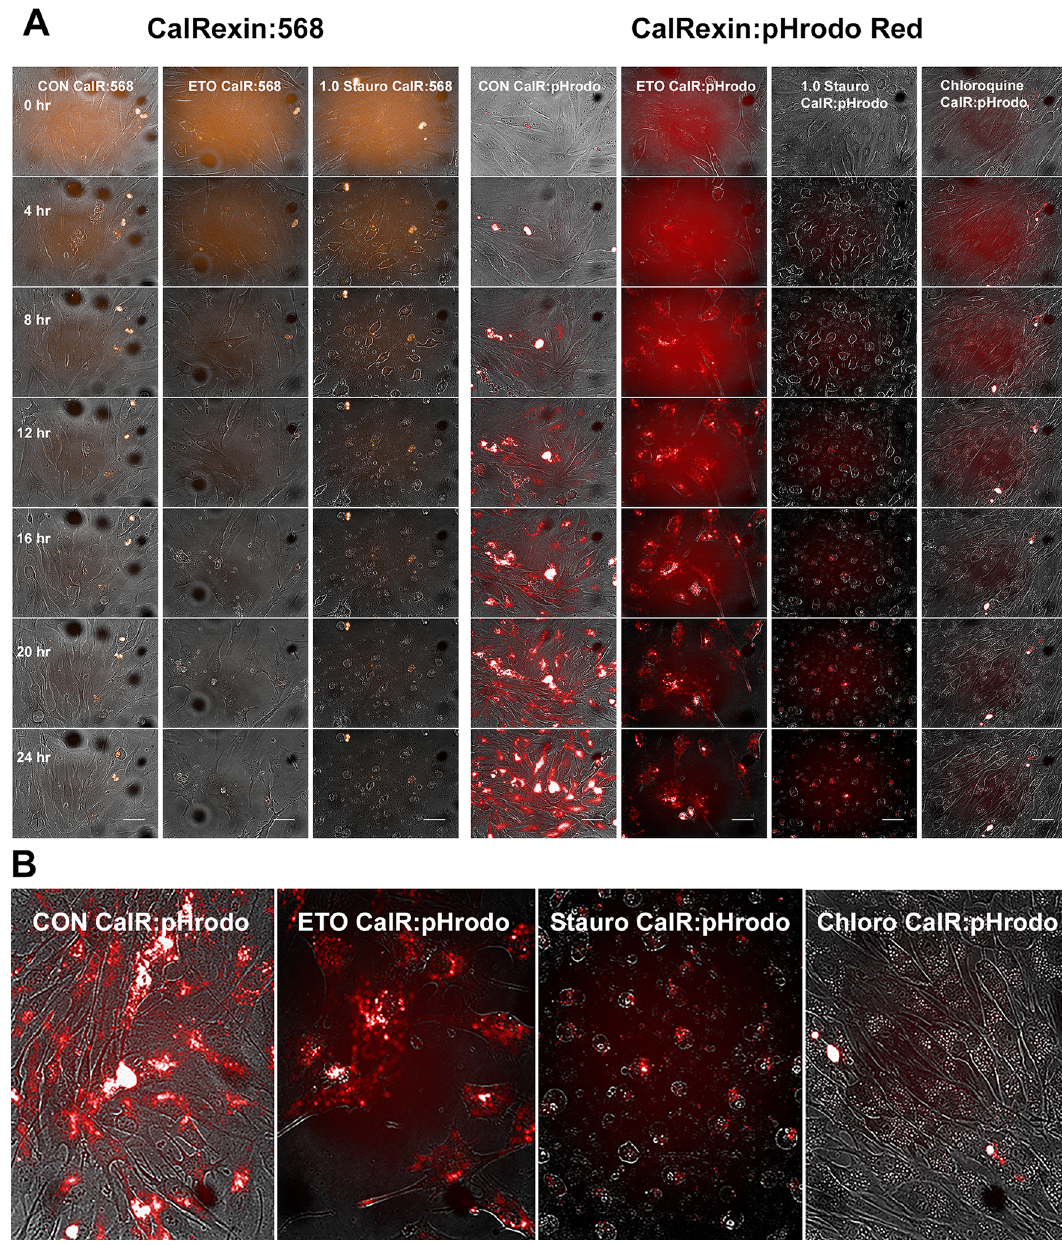
Figure1.ImagingautophagyandapoptosisinMG63inrealtimecellsontheOperettaplatform. (A)CalRexin TM : pHrodo Red compared to CalRexinTM:568 for imaging MG63 cells grown on Matrigel and undergoing autophagy (control [CON] starved by growth in depleted serum), or to induce apoptosis treated with 50 μ M etoposide or 1 μ M staurosporine, or treated with 50 μ M chloroquine to inhibit formation of autophagolysosomes. 4 Images were recorded every 30 minutes on the Operetta platform (Images displayed above were captured at 0, 4, 8, 12, 16, 20 & 24 hours). The scale bar in the 24-hour images is 50 μ m. (B) Enlarged images recorded at 20 hours. Note that chloroquine known to inhibit the fusion of autophagosomes with lysosomes to form autophago-lysosomes